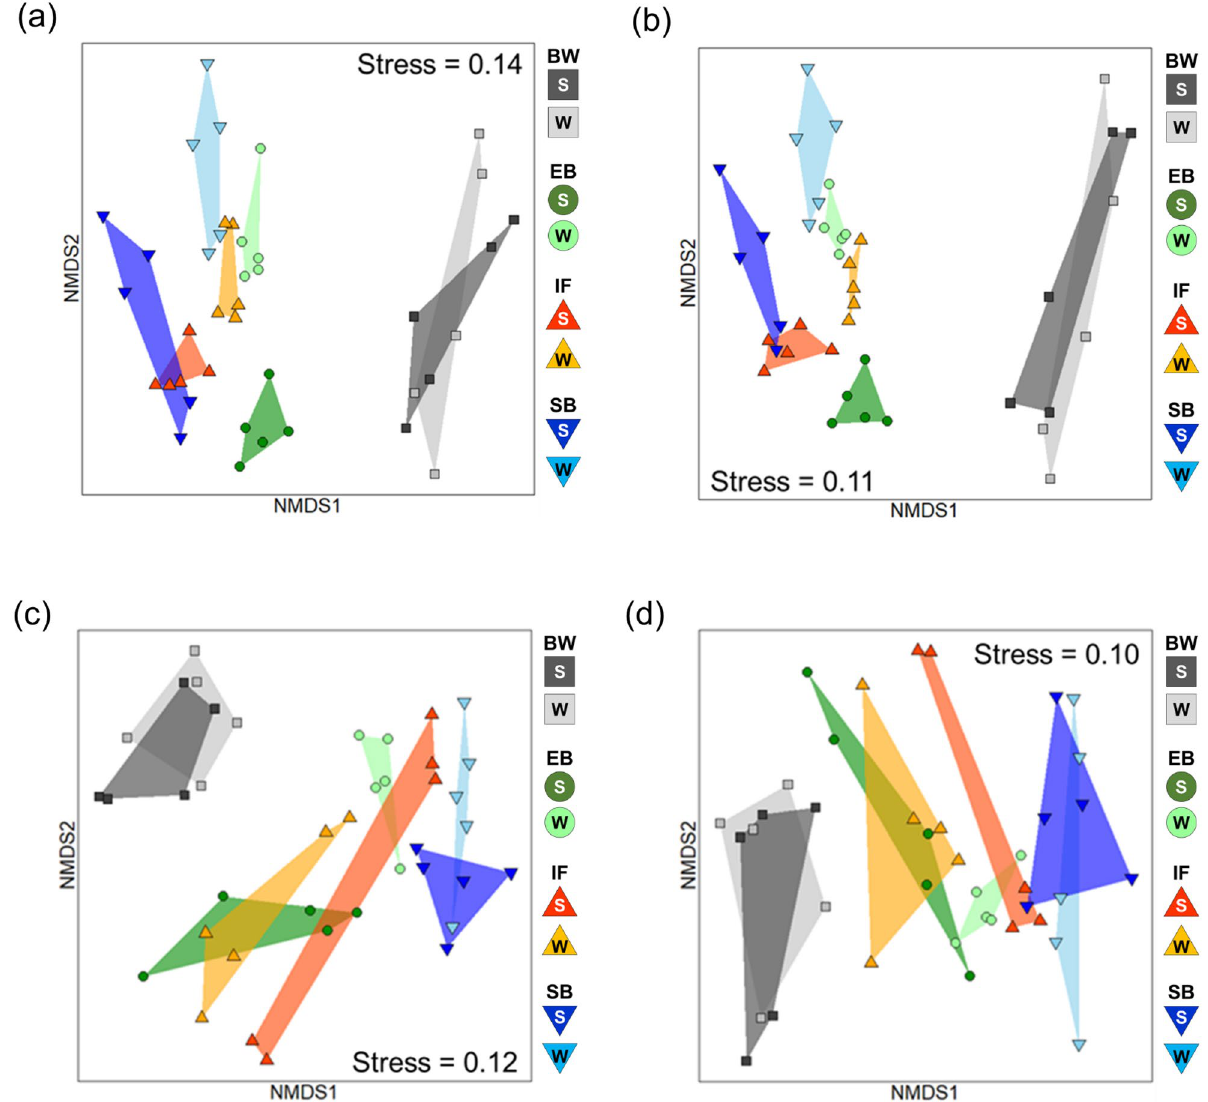
Figure 4. Non ‐ metric multidimensional scaling (NMDS) ordinations of ( a ) species compositions, ( b ) species compositions and abundances, ( c ) abundance compositions based on primary feeding type, and ( d ) abundance compositions based on common life forms. The four different symbols indicate subsites in each habitat. Convex hulls enclosed by symbols indicate the dispersion of community composition within habitats. Habitat abbreviations are as shown in Fig.